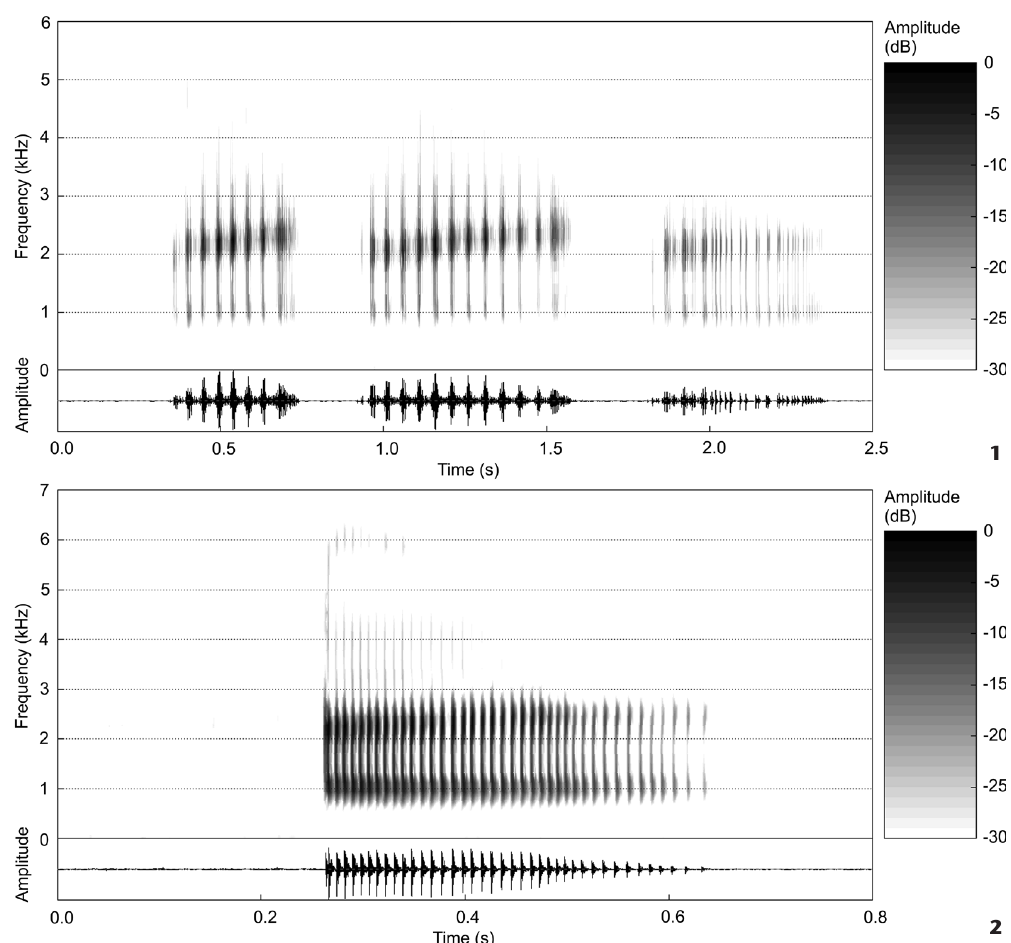
Figure 1-2. Advertisement (1) and aggressive (2) calls of Hypsiboas abopunctatus from Barro Alto, Goiás, Brazil. Above audiospectrogram, below oscillogram. (1) Air temperature = 23.4°C, Air humidity = 68%, SVL = 51,84 mm; (2) Air temperature = 19,8°C; Air humidity = 88%; SVL = 50,27